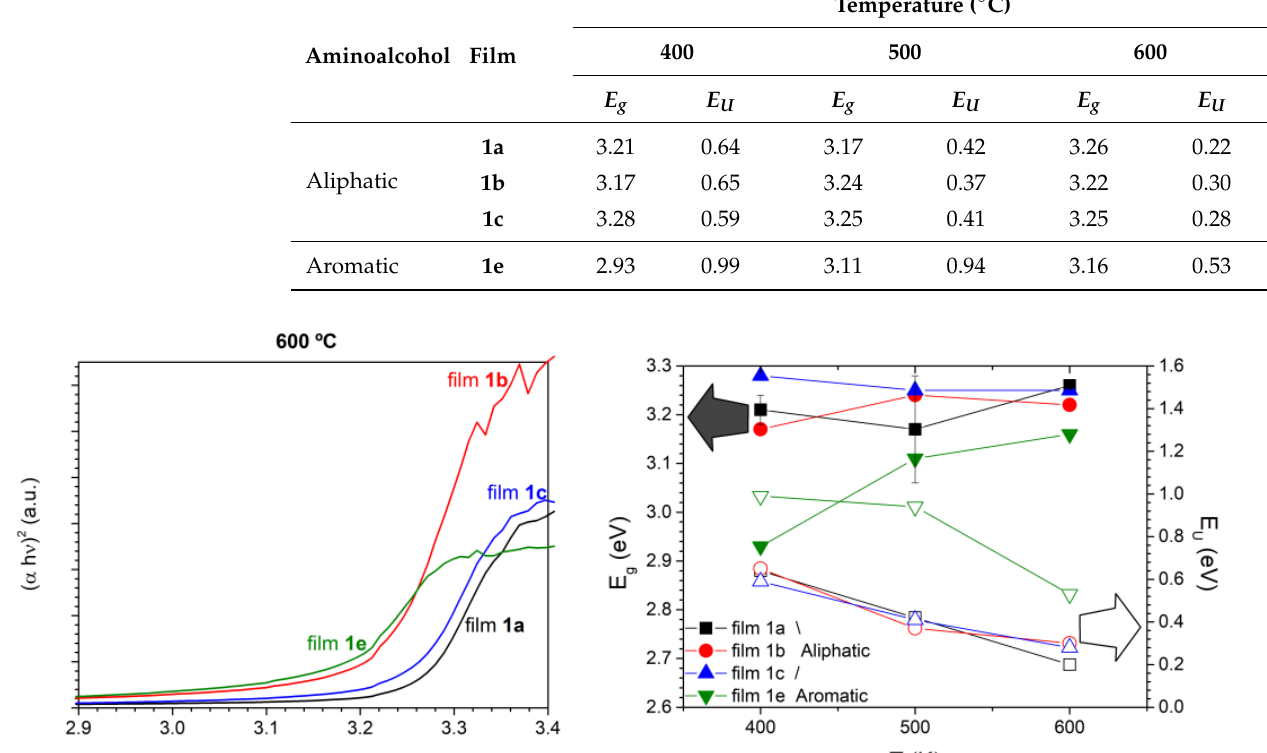
Figure 8. Tauc’s plots of the films annealed at 600 °C ( left ) and graphical summary of gap and Urbach’s energies for every sample annealed at 400, 500, and 600 °C ( right ). Error bars correspond to data dispersion due to different sets of measurements, and for clarity reasons are only included for 1a E g . All the aliphatic films present rather similar behaviors, progressing in a